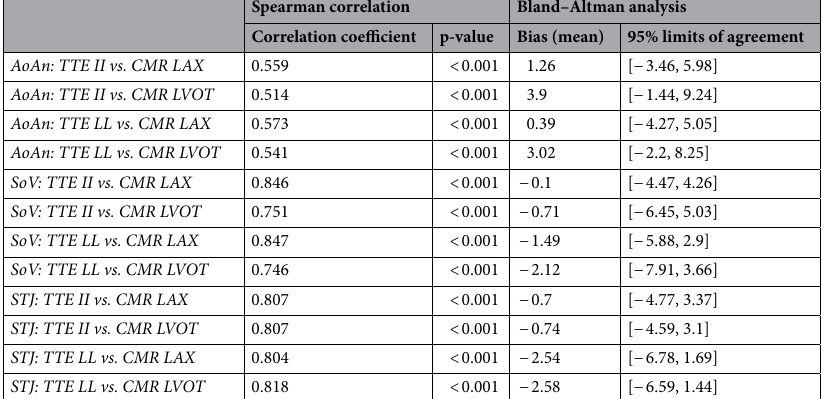
Spearman correlation Bland–Altman analysis Correlation coefficient p-value Bias (mean) 95% limits of